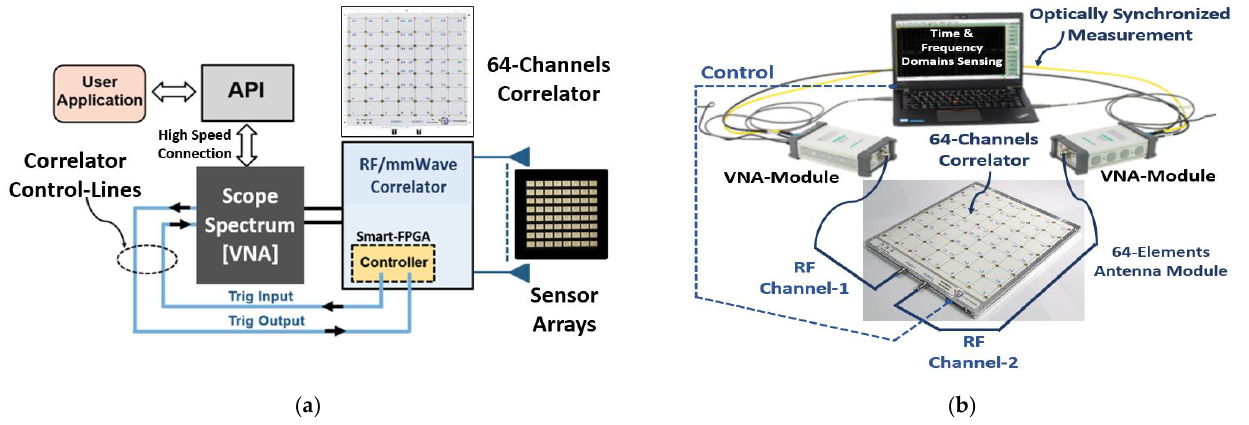
Figure 10. 64-Channels correlator ( a ) module combined with 64 broadband sensor-array elements. Optically synchronized VNA modules for broadband extraction of correlation functions ( b ).